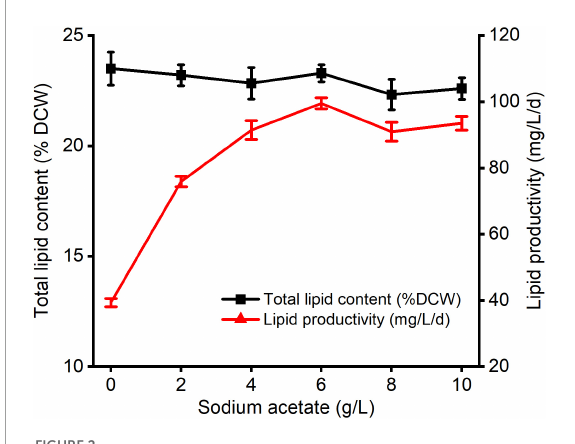
FIGURE2 The changes of total lipid content and lipid productivity in C. reinhardtii under different carbon